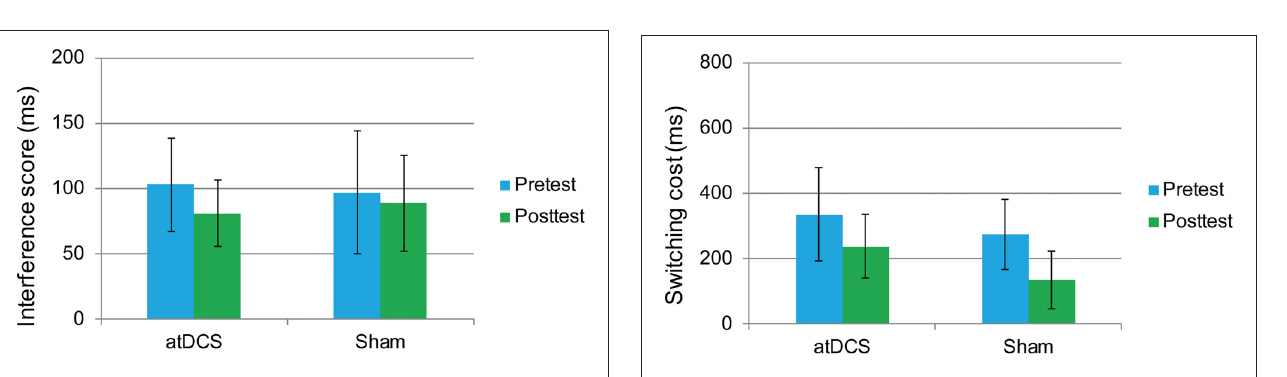
FIGURE 5 | The plot displays the mean interference score of the RT in each group (anodal transcranial direct current stimulation and sham transcranial direct current stimulation) at pretest and posttest. Error bars represent standard errors of the mean. atDCS, anodal transcranial direct current stimulation.